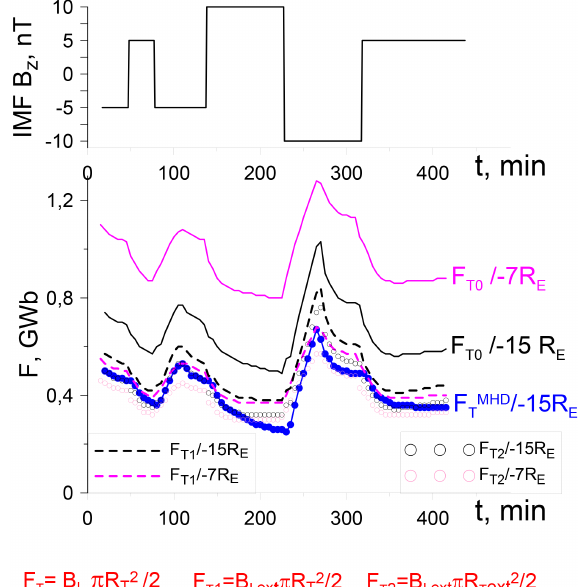
Figure 3. Results of the simulation BAT- SRUS_Gordeev_110309_1. Top panel: IMF B z variation, shifted by convection to x = − 15 R E . Bottom panel: F T 0 (solid lines), F T 1 (dashed lines) and F T 2 (circles) values, calculated based on the “measurements” at different x distances ( y = 0, z = − 10 R E ) compared with F MHD value, obtained by direct integration through T the cross section x = − 15 R E (thick blue